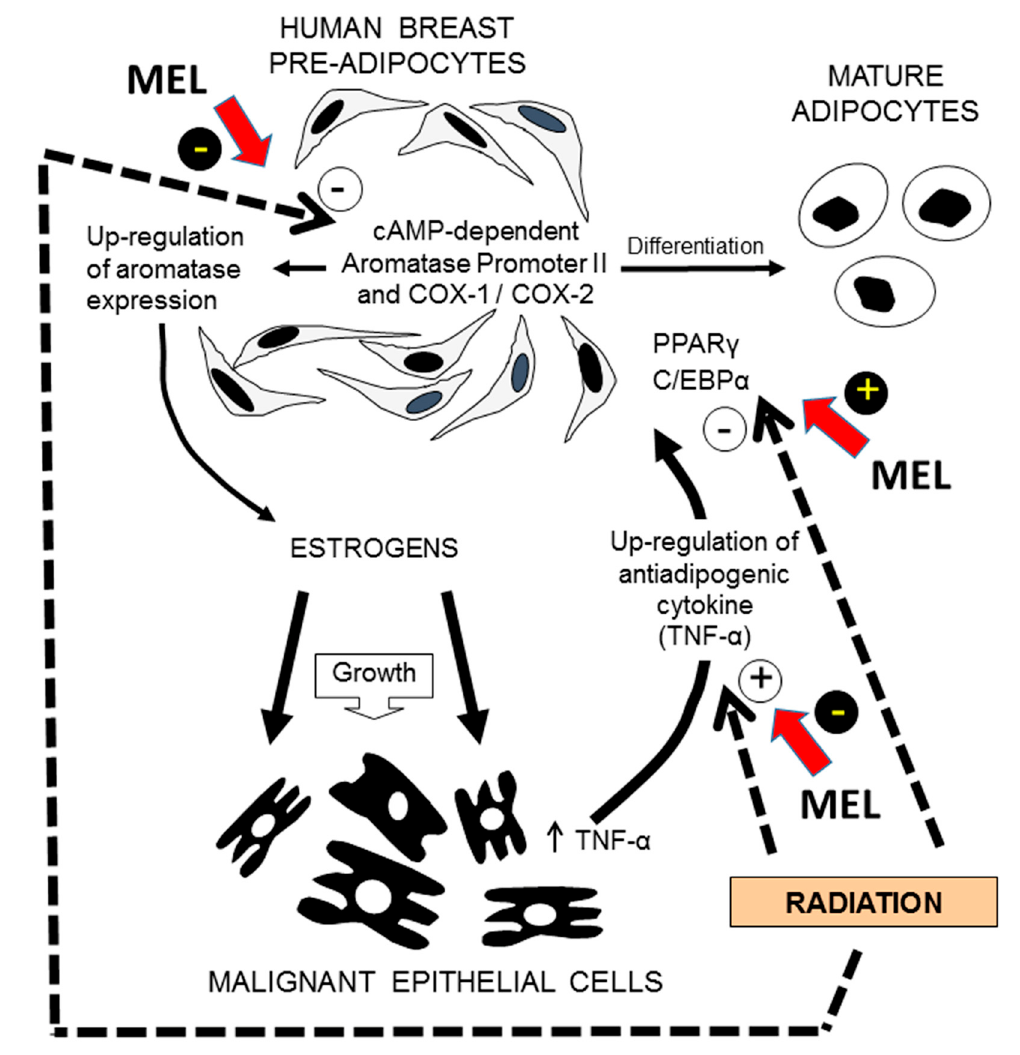
Figure 3. Modulation by melatonin of the pre-adipocytes response (differentiation, aromatase activity and expression) to ionizing radiation. In co-cultures of human breast pre-adipocytes and human breast cancer cells melatonin (MEL) counteracts the inhibitory action of radiation on differentiation of pre-adipocytes, by increasing C/EBP α (CCAAT/enhancer binding protein alpha) and PPAR γ (peroxisome proliferator-activated receptor gamma) expression and by decreasing TNF α (Tumor necrosis factor α ) expression, an anti-adipogenic cytokine secreted by breast malignant epithelial cells. Melatonin also potentiates the inhibition induced by radiation on aromatase activity and expression by increasing the down-regulation of aromatase promoter II, COX-1 and COX-2 expression. Figure drawn from data published by González-González et al. [87].